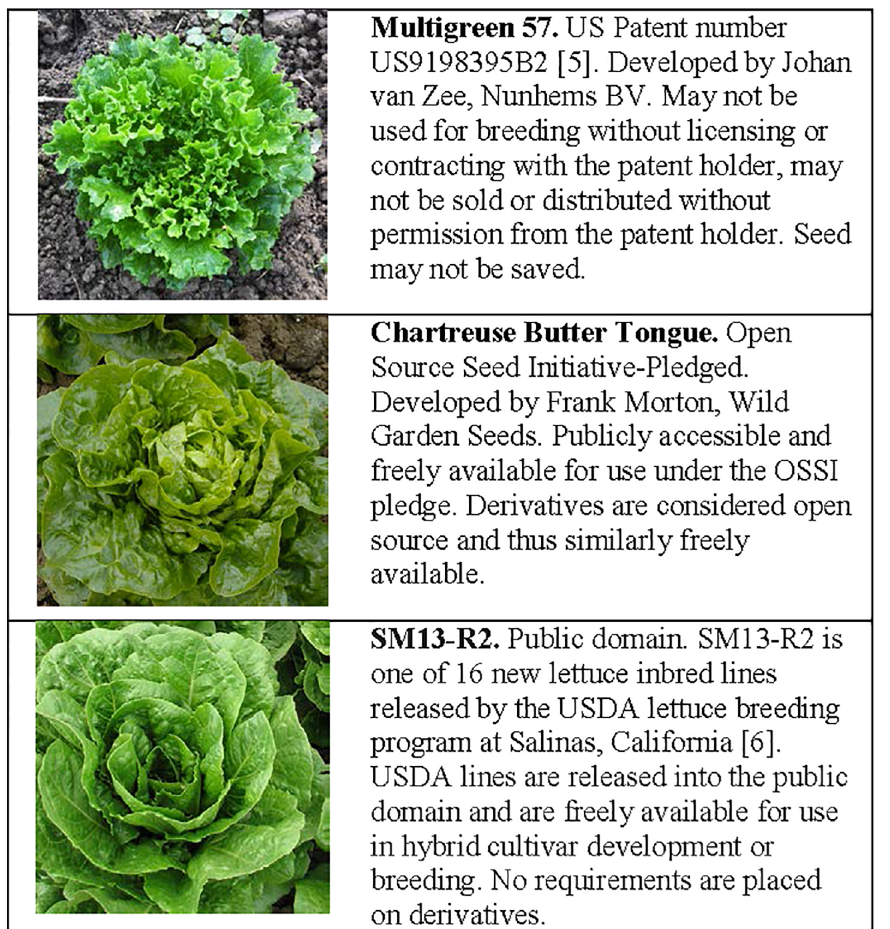
Fig 1. Lettuce cultivars released using three different mechanisms. Plant cultivars released into the public domain are often utilized in developing subsequent cultivars [8] that are then protected using various forms of intellectual property rights (IPR). The following lettuce cultivars are released using a variety of IPRs that allow subsequent users to utilize cultivars in future breeding in different ways. Photo credits : Multigreen 57 , Osbourne Seed Company; Chartreuse Butter Tongue , Karen Morton; SM13-R2 , Jose Orozco , USDA/ ARS .